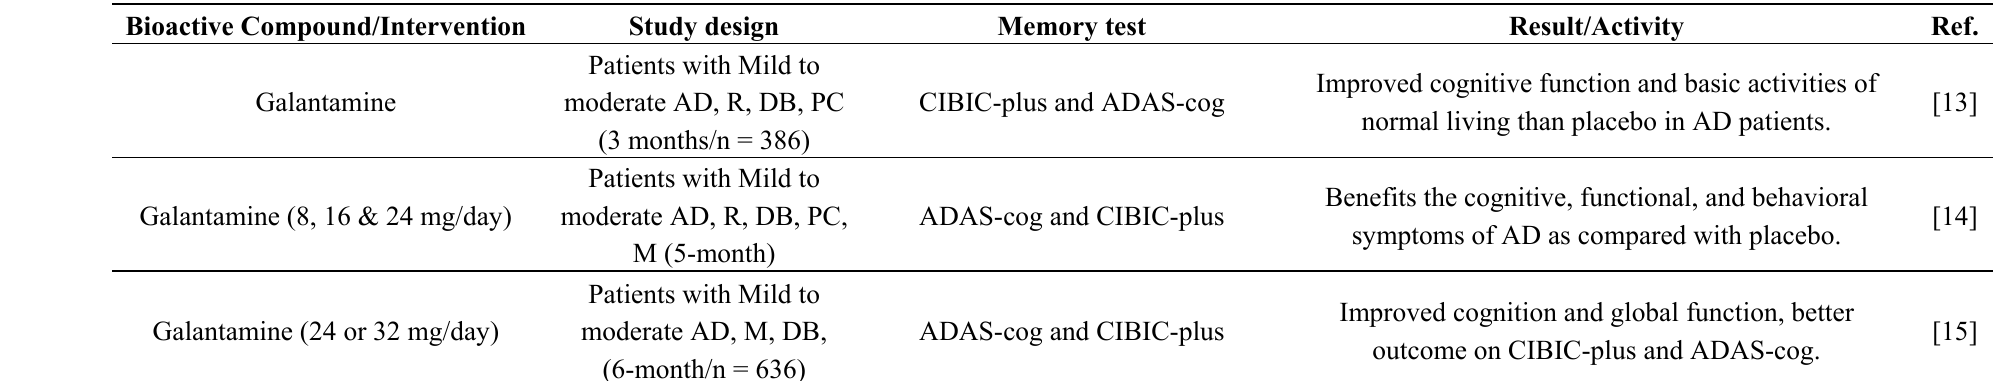
Table 1. Natural bioactive compounds in clinical